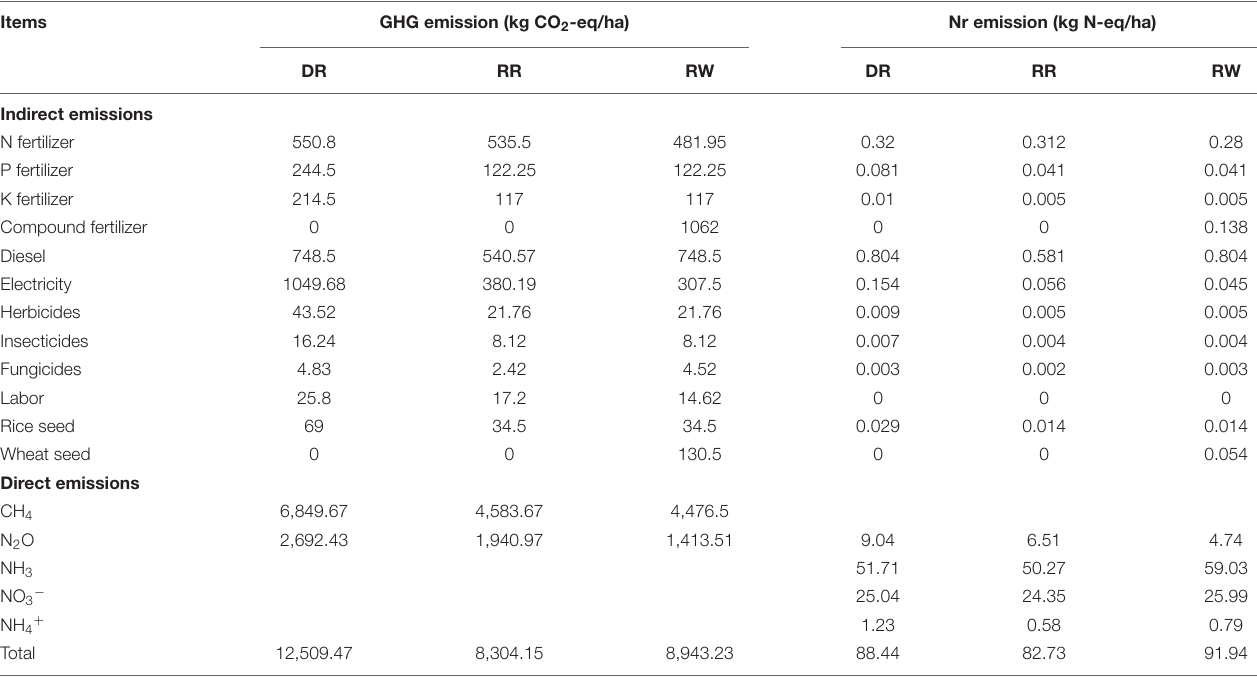
FIGURE 3 | Average contribution of different sources to the carbon emission of the three cropping systems. DR, double-rice system; RR, ratoon rice system; and RW, rice-wheat system. TABLE 5 | Yearly average greenhouse gases (GHGs) and reactive nitrogen (Nr) emissions for the three rice cropping